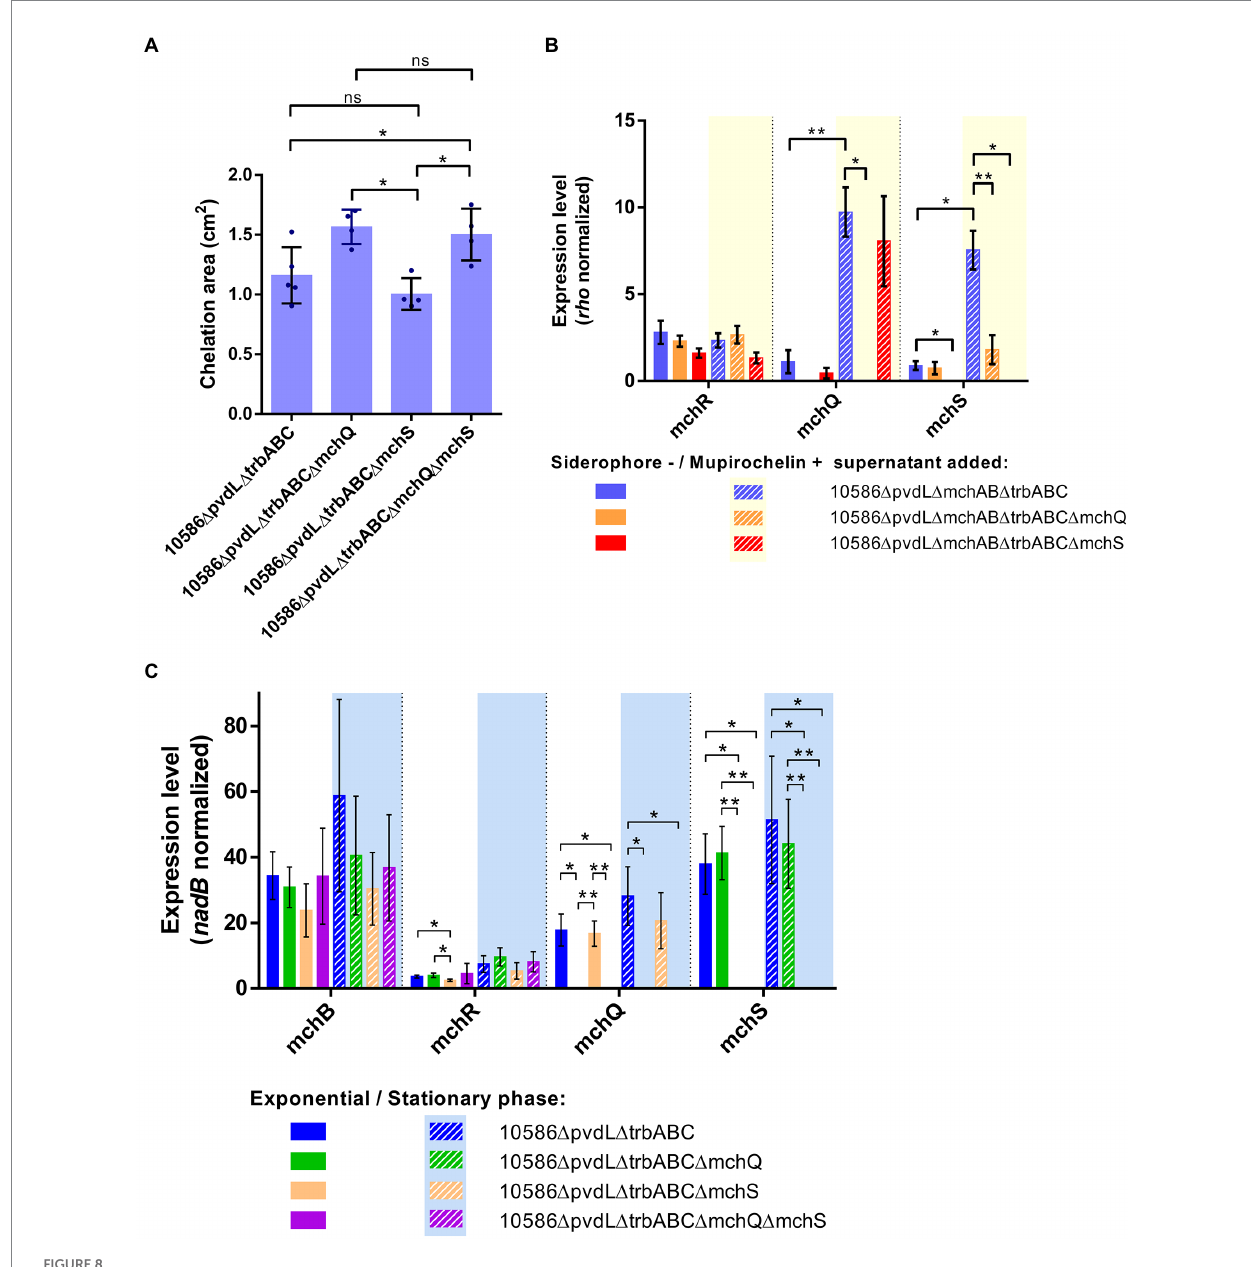
FIGURE 8 Comparison of MchQ and MchS TonB-dependent membrane receptors involvement in mupirochelin transport and biosynthesis. (A) Results of CAS assay for mutants in a pyoverdine and triabactin negative background with additional deletion in mchQ or mchS genes. Deletion of mchS in 10586 ∆ pvdL ∆ trbABC ∆ mchS does not affect the area of chelation produced in the CAS medium. On the contrary both 10586 ∆ pvdL ∆ trbABC ∆ mchQ and 10586 ∆ pvdL ∆ trbABC ∆ mchQ ∆ mchS mutants show a larger surface of chelation in CAS medium compared with 10586 ∆ pvdL ∆ trbABC and 10586 ∆ pvdL ∆ trbABC ∆ mchS, suggesting that mchQ plays a role in mupirochelin uptake by the strain. All dots represent biological replicates ( n = 4). Results of Mann–Whitney U -test for between-group pairwise comparison: ns p > 0.05, * p < 0.05, ** p < 0.01, *** p < 0.001. (B) Expression levels of mchR, mchQ and mchS genes in siderophore-negative strains incubated with siderophore-negative or mupirochelin-positive supernatants ( n = 3). mchR expression level is not influenced by the addition of mupirochelin in the culture medium. In the strains expressing mchQ, the transcription level of the TonB-dependent receptor coding genes is increased by mupirochelin supplementation. The specific deletion of mchS does not influence the expression level of the other studied genes. However, the expression level of mchS is not affected by the addition of mupirochelin in the culture medium when mchQ is deleted, suggesting that MchQ plays a role in mupirochelin uptake. Results of unpaired Student’s t-test with Welsh’s correction * p < 0.05, ** p < 0.01, *** p < 0.001. (C) Influence of mchQ and mchS deletions on mch transcription. Expression levels of mchB, mchQ and mchS do